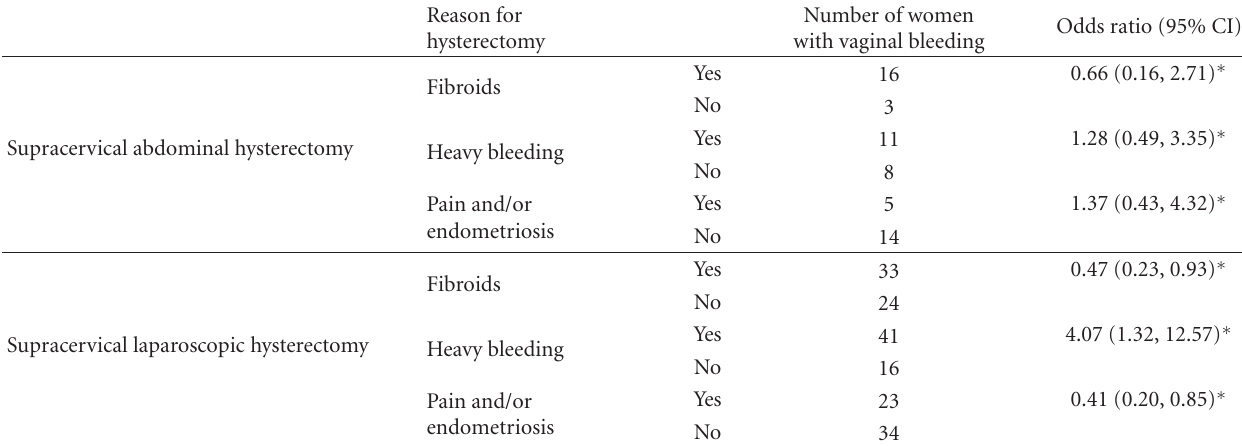
Table 1: Adjusted risk estimates for experiencing persistent vaginal bleeding following abdominal and laparoscopic supracervical